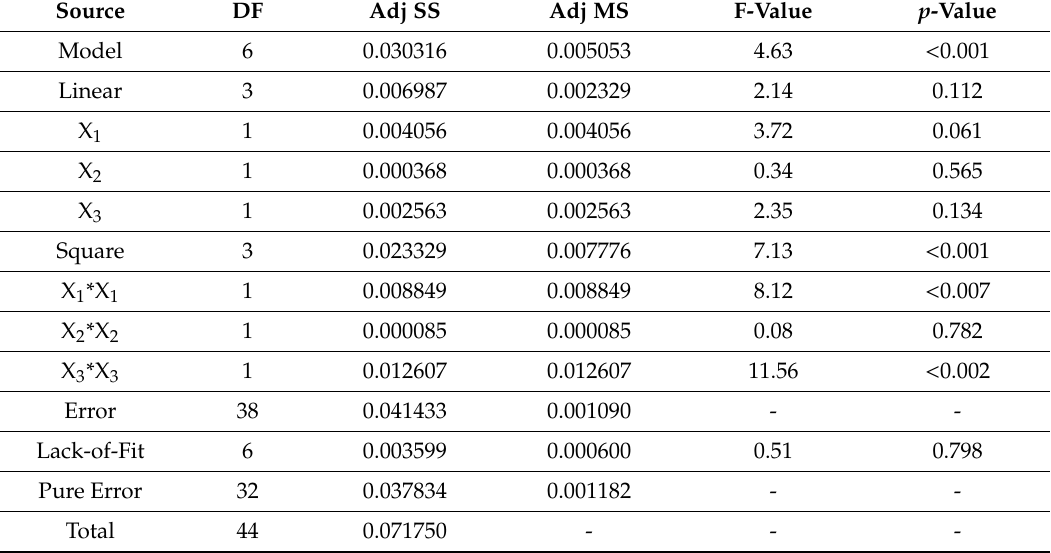
Table A2. Results of ANOVA analysis of surface roughness R a